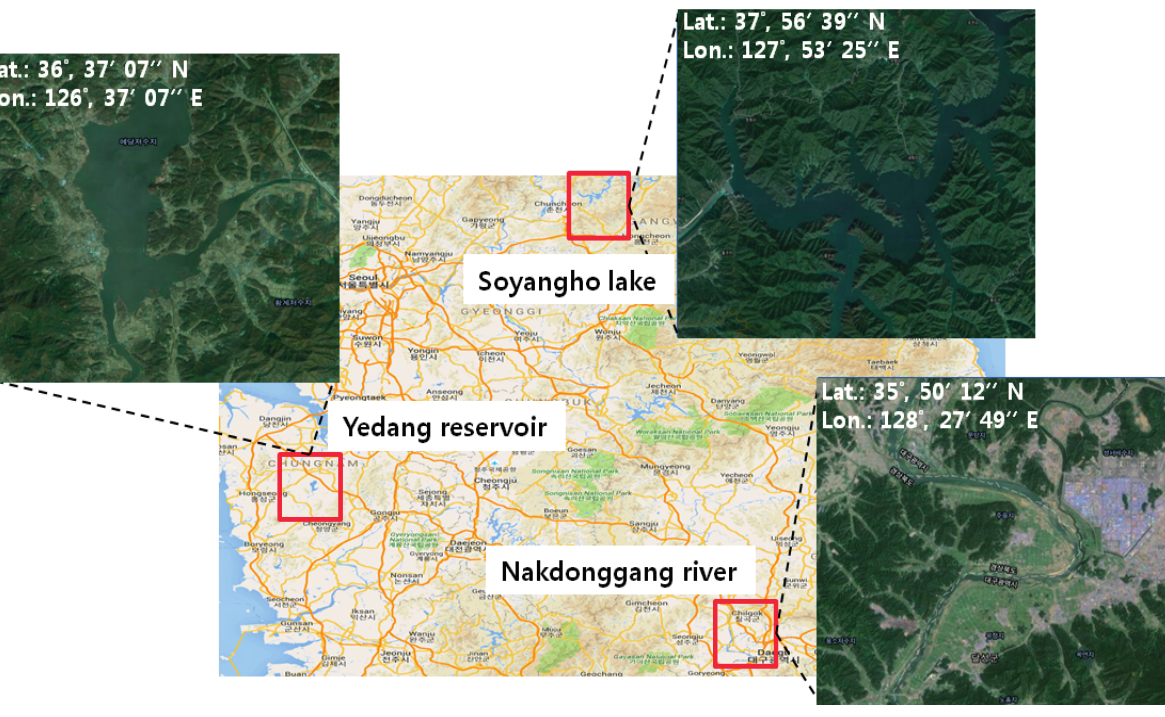
Figure 3. Three areas of Korea with different water types and topologies for performance evaluation. These images include many types of water features such as rivers, lakes and